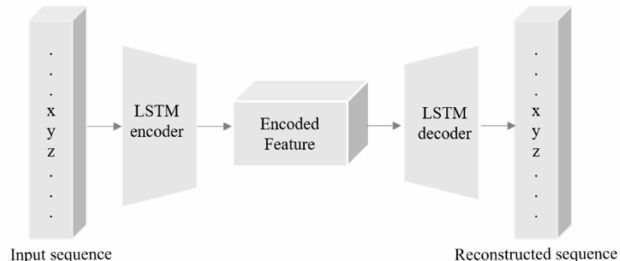
Figure 6. The internal structure of LSTM-AE where the first LSTM layer used as an encoder and the second is a